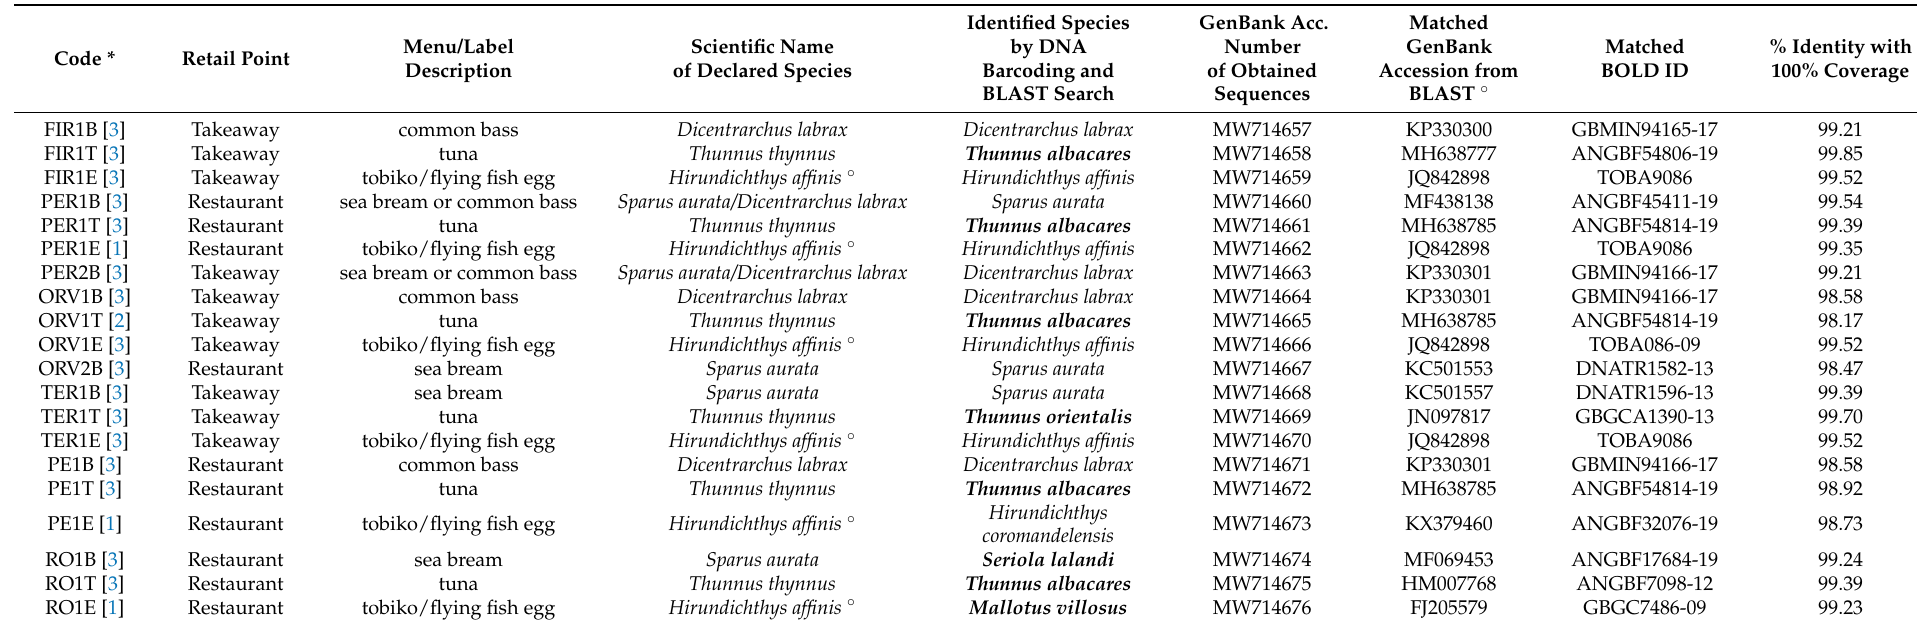
Table 2. Sushi sampling in Central Italy. In square brackets, the number of processed samples for each sushi product. In bold, misdescription cases.